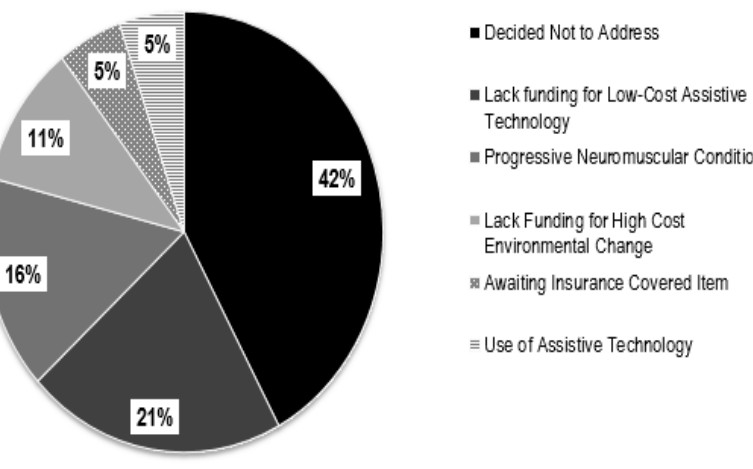
Figure 6. Reasons for perception of performance change scores of two or lower (n=19) using the